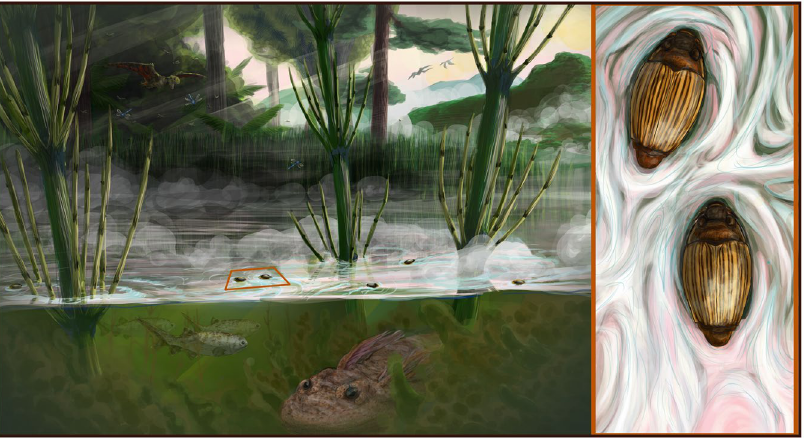
Figure 4. Habitat reconstruction of Mesogyrus antiquus from the Karabastau Formation. The Karabastau formation is the remains of a large, permanent, mountain lake from the Late Jurassic of Karatau, Kazakhstan. In the background the pterosaur, Batrachognathus volans , chases an odonate over the lake, while on waters’ surface the heterogyrine whirligig, Mesogyrus antiquus , spins about. Beneath, some Pteroniscus fish swim by, while the salamander Karaurus sharovi settles into the sediment. The right panel shows the dorsal habitus of M . antiquus in detail. Artwork by Trevor